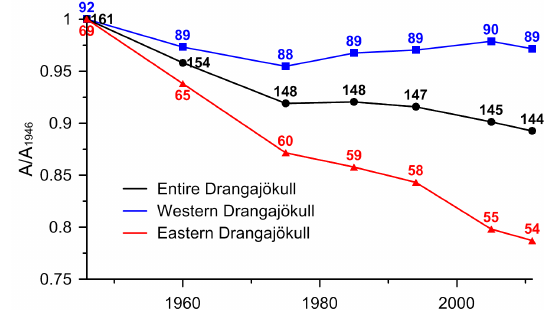
Figure 5. The relative area change of the entire Drangajökull ice cap, the western and eastern sections of the ice cap. The purple lines in Fig. 6 show the ice divides; they are used to define the east and west sections of the glacier. Labels give the glacier area in square kilometers at each